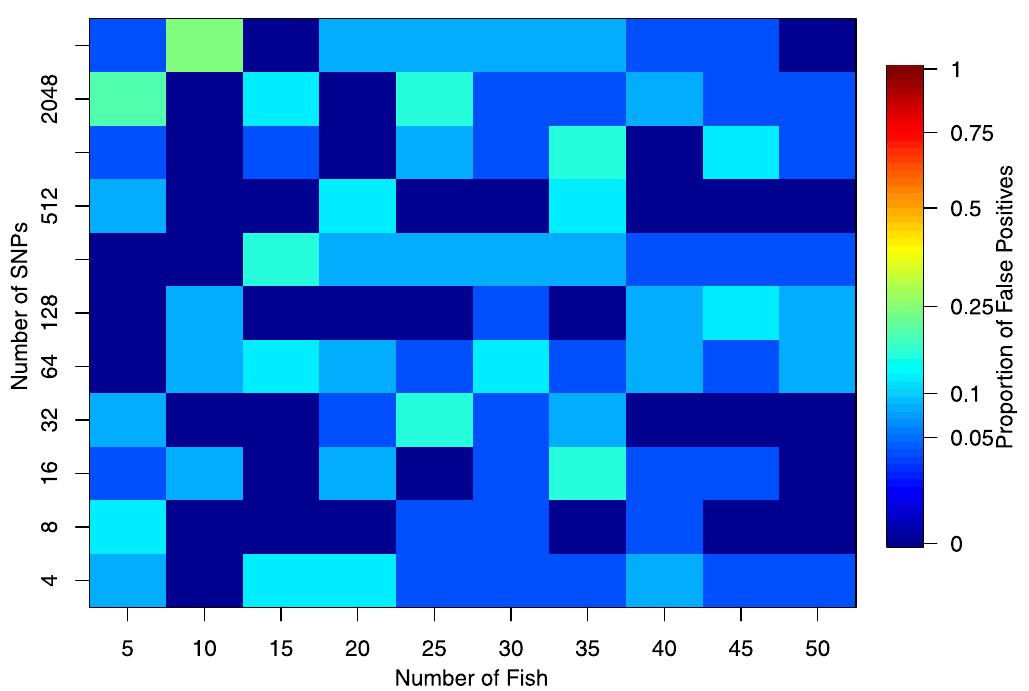
Fig 4. Results from genetic profile (hypothesis) testing on data with randomised location groups. The figure contains the proportion of false-positive tests significant at the α = 0.05 level.